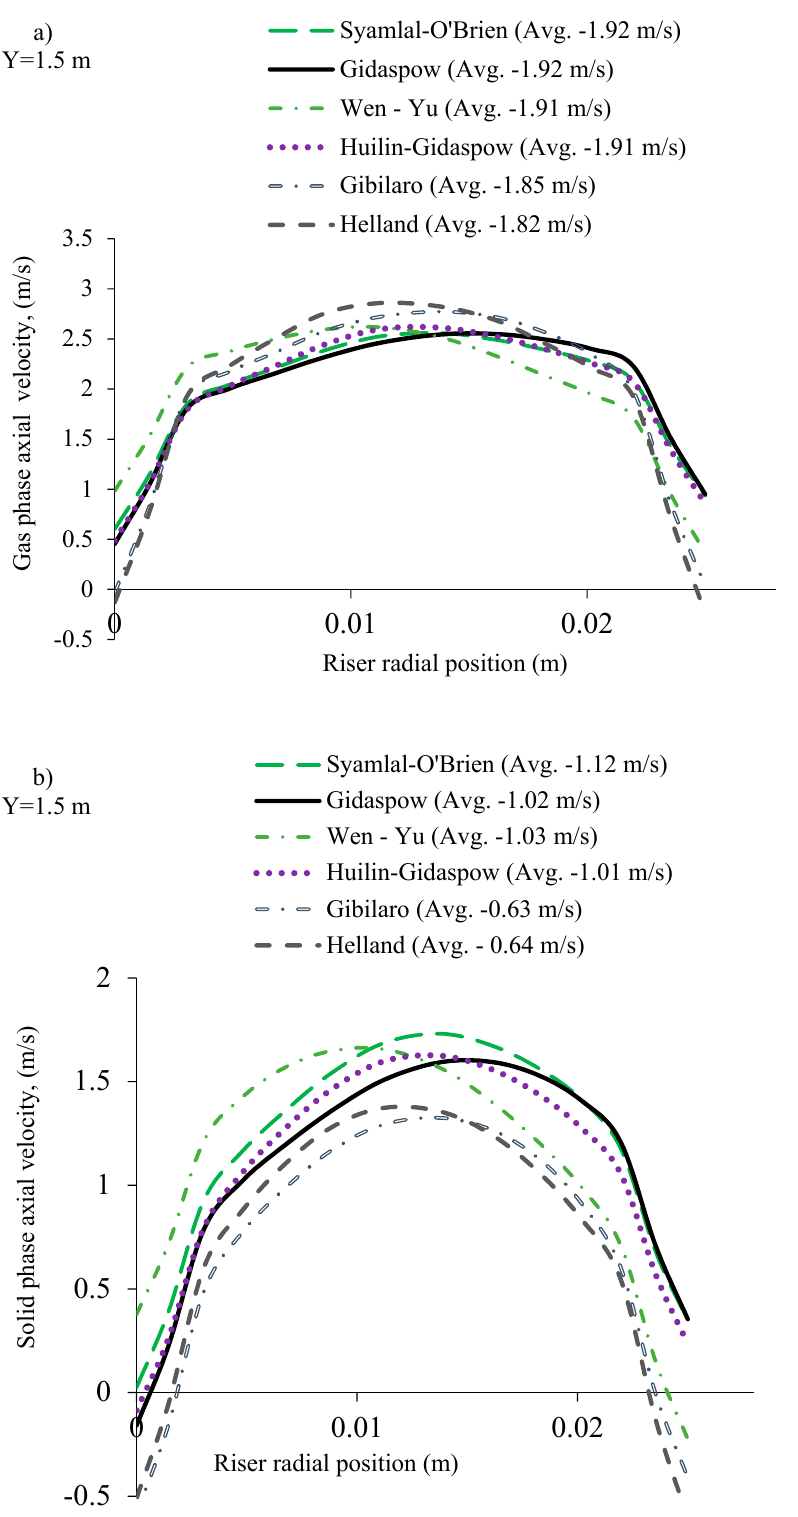
Figure 5. Influence of drag models ( a ) gas phase axial velocity ( b ) solid phase axial velocity at H = 1.5 m. Figure 6 shows the time-averaged axial solid holdup profiles from di ff erent drag models. CFB riser experimental data exhibited L-shaped solid holdup profile. Syamlal-O’Brien, Gidaspow, Wen-Yu and Huilin-Gidaspow drag model predicts similar axial solid holdup and able to reproduce